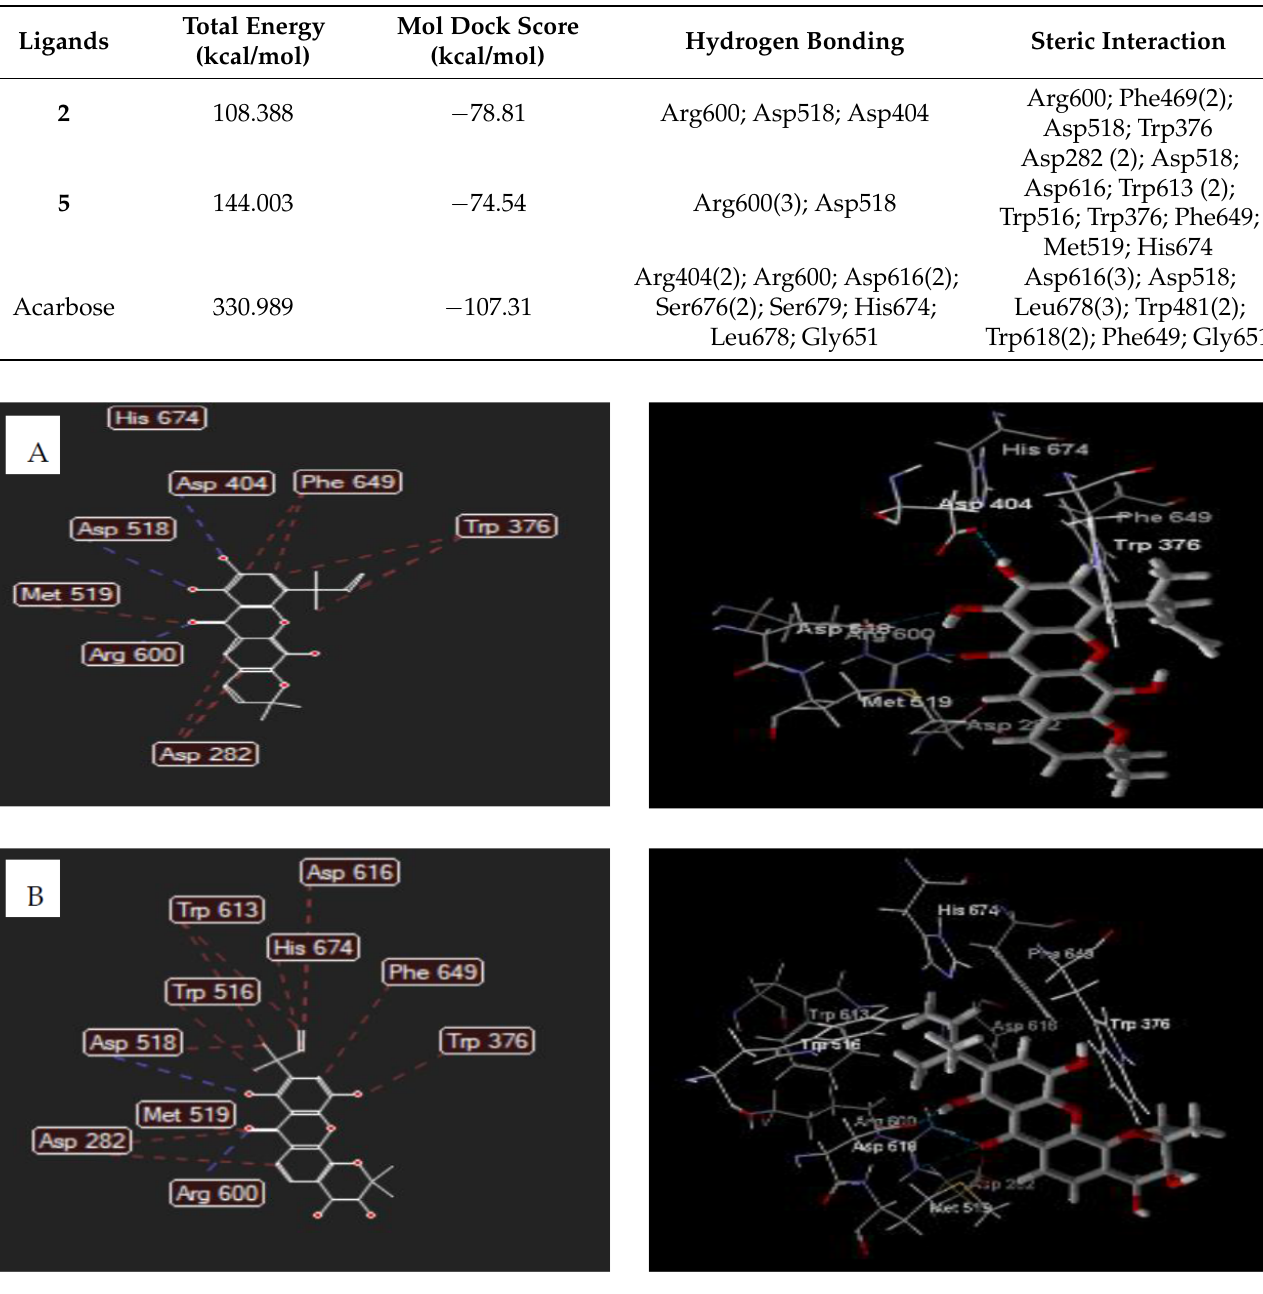
Table 6. The total energy, MDS, and interacting residues of 2 and 5 to human lysosomal acid-alpha-glucosidase enzyme (5NN8).